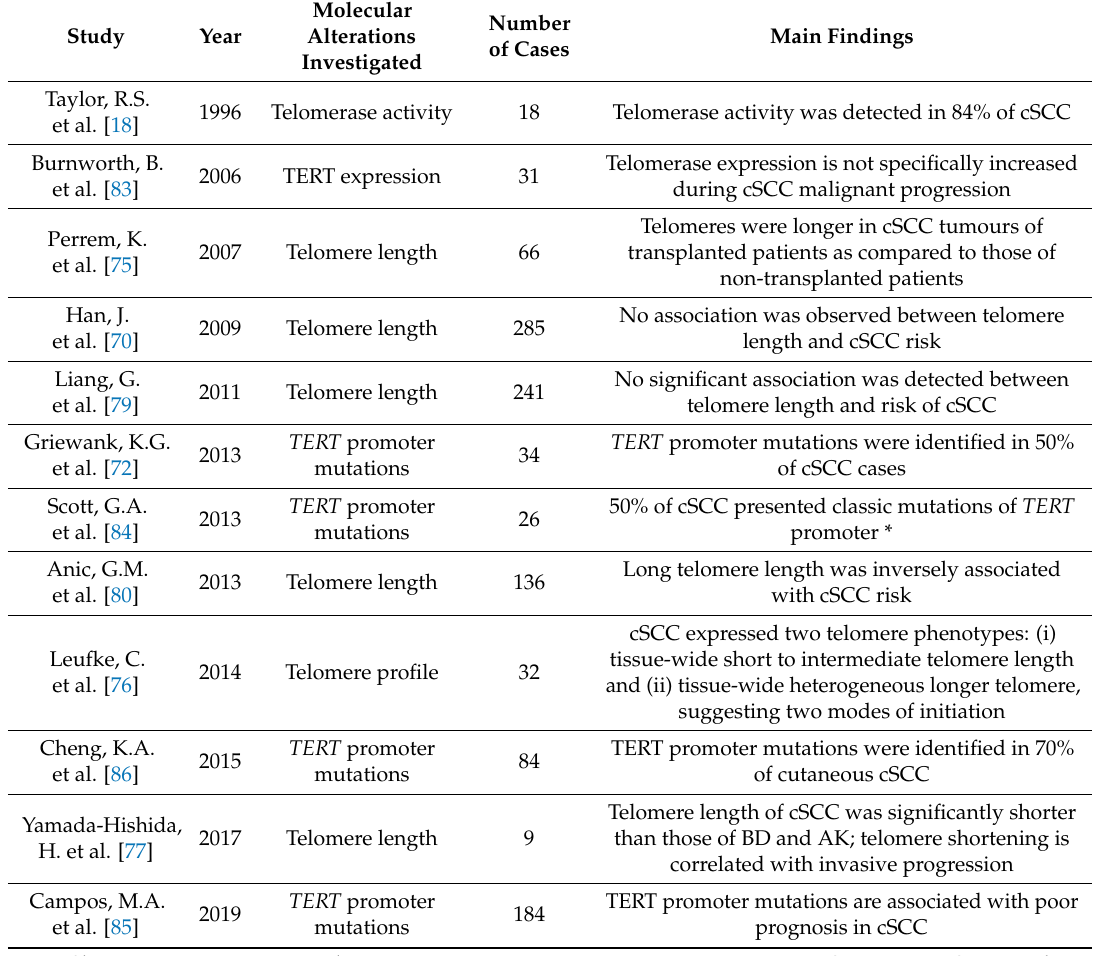
Table 1. Overview of main findings reported on telomere biology and telomerase activity in cSCC.